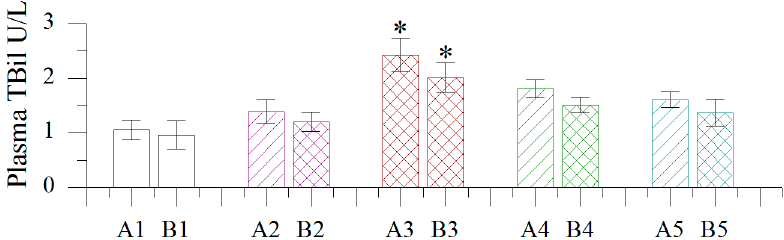
Figure 4. Effect of different concentrations of volatile oil from Blumea balsamifera (BB oil) on plasma TBili levels in rats. 1–5: CK, Olive oil, 100% BB oil, 50% BB oil, 20% BB oil; A, B: normal skin, wound skin; *: Columns labeled by * are significantly different from others by Duncan’s test at p <